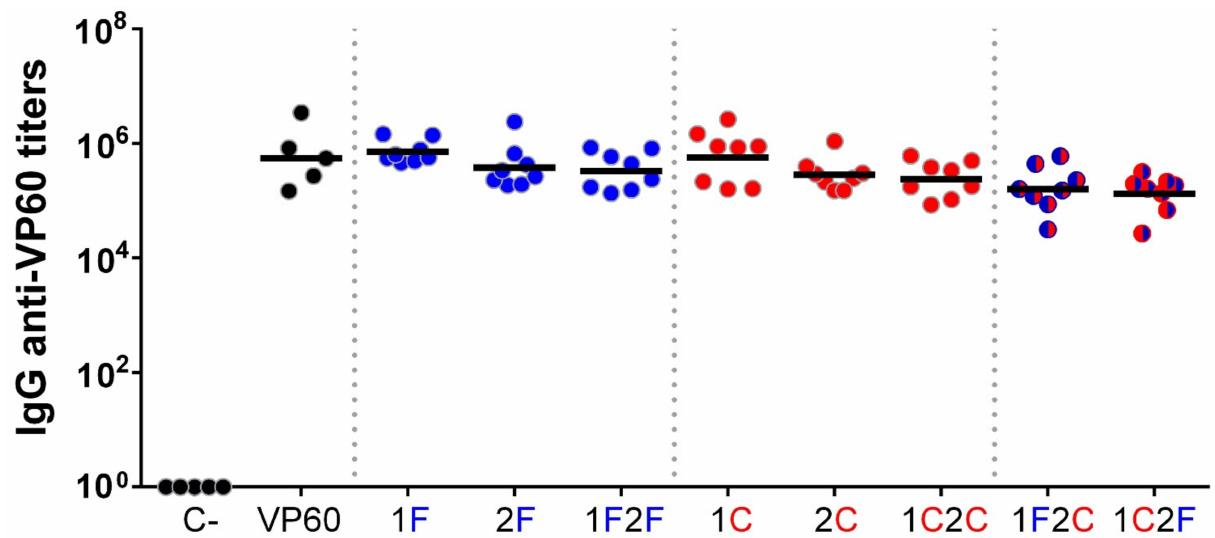
Figure 4. Serum IgG anti-VP60 antibody titers induced by immunization with the chimeric RHDV VLPs. Sera samples from groups of mice inoculated twice with the indicated VLPs were analyzed by ELISA. Anti-VP60 serum IgG antibody titers were determined using RHDV VLPs as antigens. Each symbol represents the value for an individual mouse ( n = 5 for control groups and n = 8 for chimeric VLP groups). GMTs were calculated for all groups (solid